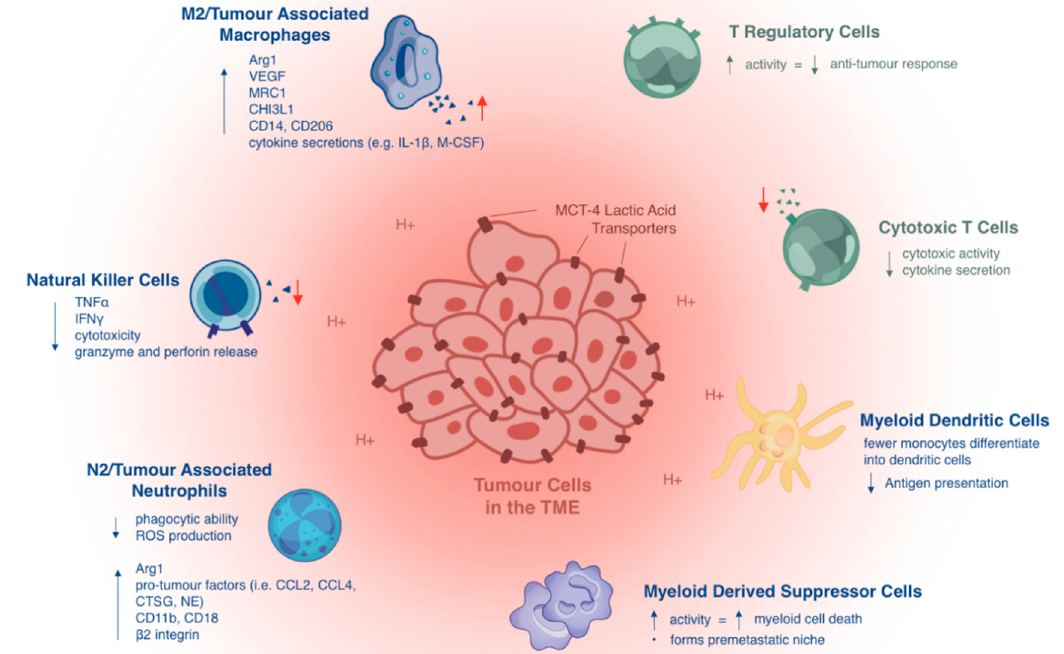
Figure 1. Lactic acid in the tumor microenvironment suppresses the antitumor immune response by negatively regulating innate and adaptive tumor-infiltrating immune cells. First, lactic acid impairs monocyte differentiation into dendritic cells (DCs) and further decreases their antigen-presentation functions. Second, lactic acid inhibits the antitumor activities of immune effector cells, including natural killer and cytotoxic T cells. Lastly, lactic acid promotes the infiltration of immunosuppressive cell types, such as M2 macrophages (M2) -like tumor-associated macrophages, N2 neutrophils (N2)-like tumor-associated neutrophils, myeloid-derived suppressor cells, and regulatory T cells, which can effectively inhibit the antitumor immune response and contribute to cancer immune escape.